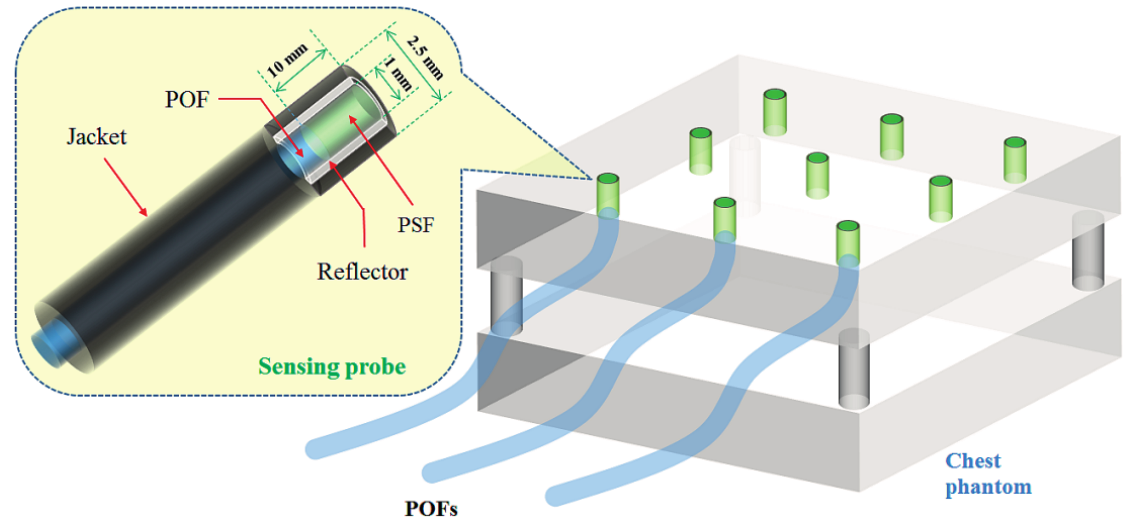
Figure 1. Inner structure of the sensing probe and the arrangement of nine sensing probes at each center of nine equal parts on the top of the ANSI sensitometry chest